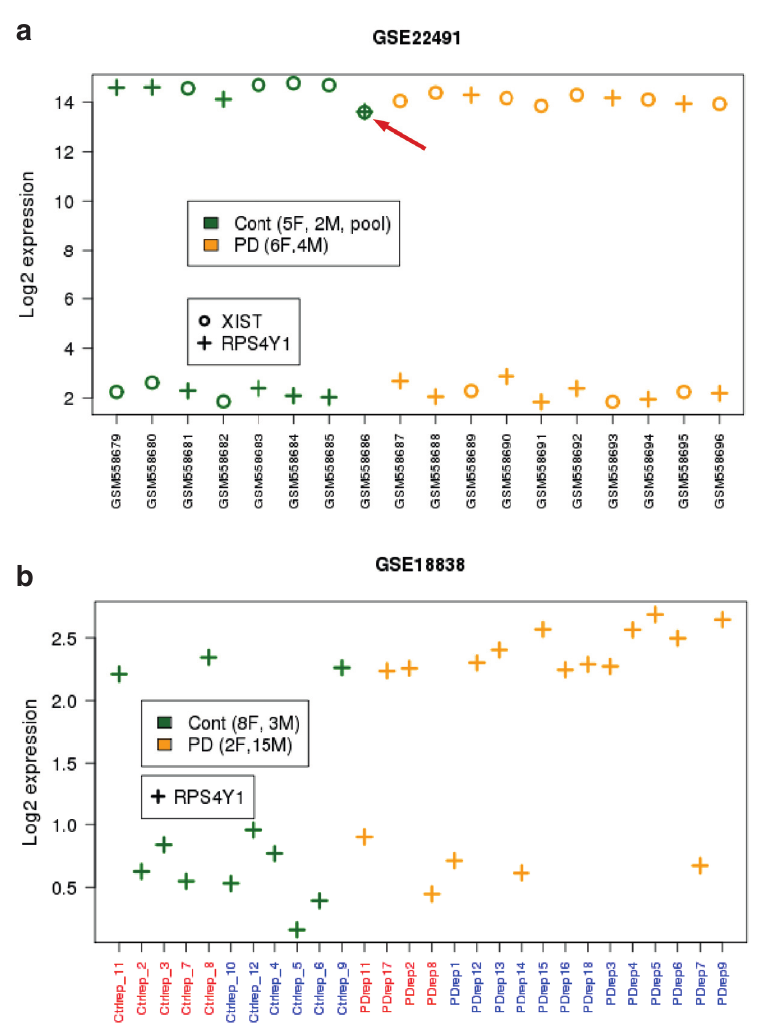
Figure S1. Disagreement between gene-based and annotated sex in three datasets participating in the metaanalysis of Parkinson’s disease 1,2 . Santiago and Potashkin included four datasets in their metaanalysis. When available (three out of the four datasets) we used sample characteristics provided in the associated manuscripts to identify existence of mislabelled samples. Gene-based males are defined by high RPS4Y1 and low XIST expression. Cont – control subjects (green), PD – Parkinson’s disease (orange). In brackets, the corresponding number of females (F) and males (M) reported in the original manuscript. XIST and RPS4Y1 genes were present in datasets GSE22491, but only RPS4Y1 was present in GSE18838. ( a ) Based on the sex-genes expression, dataset GSE22491 contains at two 2 mislabelled samples. Of notice, in the pooled sample (indicated by an arrow) containing equal amount of males and females, the two genes are expressed at similar levels. ( b ) This is the only dataset for which sex of individual samples was available on GEO. Red – GEO annotated females, blue – GEO annotated males. Based on the manuscript’s sample characteristics there should be 8F, 3M controls, and 2F, 15M PD. However, metadata provided on GEO, describes 5F, 6M controls, and 4F, 13M PD. Both of these annotations disagree with the gene-based sex of the samples (Cont – 8F, 3M, PD – 5F,